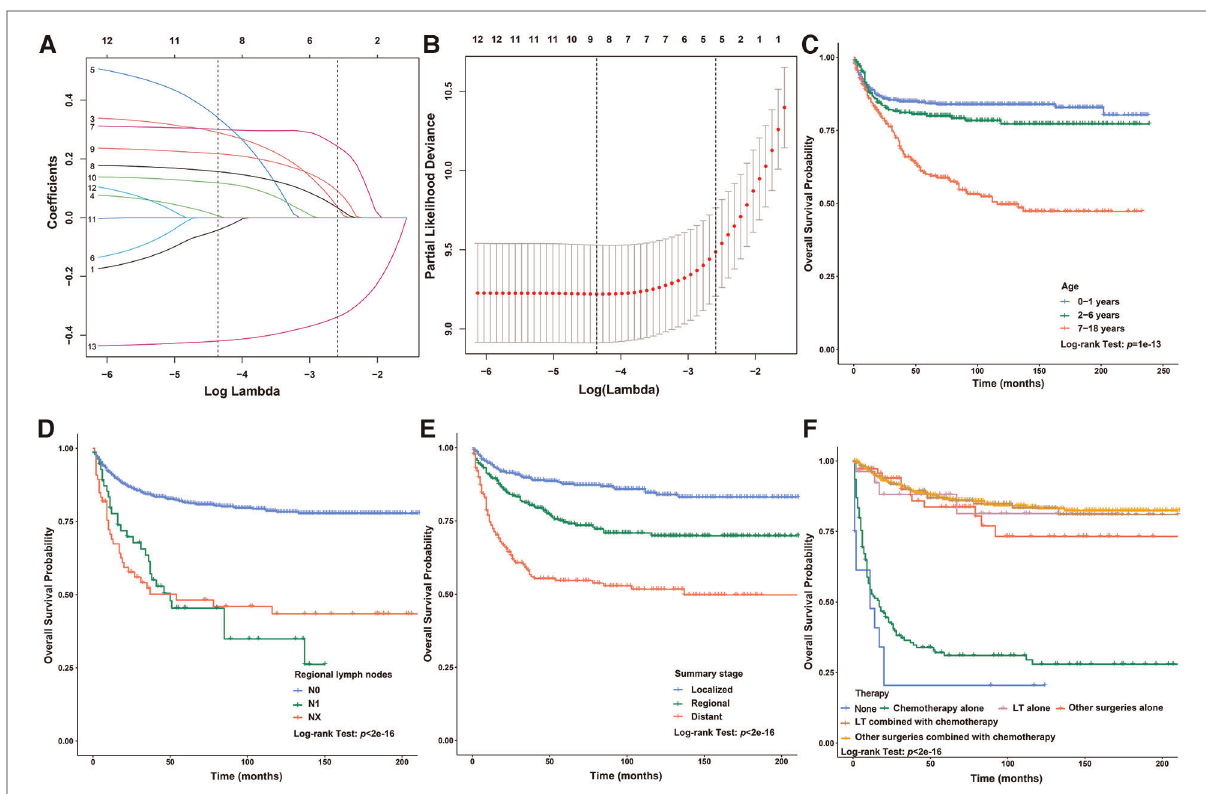
FIGURE 3 Screening variables closely related to the prognosis of children with liver cancer. ( A ) LASSO coef fi cient pro fi les of the variables of children with liver cancer. ( B ) Tenfold cross-validation for tuning parameter selection in the LASSO Cox model. ( C ) Survival curves of children with liver cancer between different age groups. ( D ) Survival curves of children with liver cancer between different N groups. ( E ) Survival curves of children with liver cancer between different summary stage groups. ( F ) Survival curves of children with liver cancer between different therapy groups.